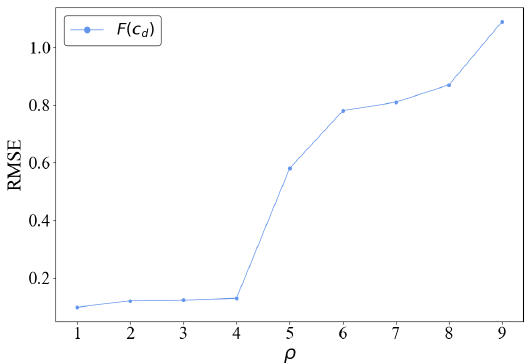
Figure 11. Experiment result according to various ρ s in terms of